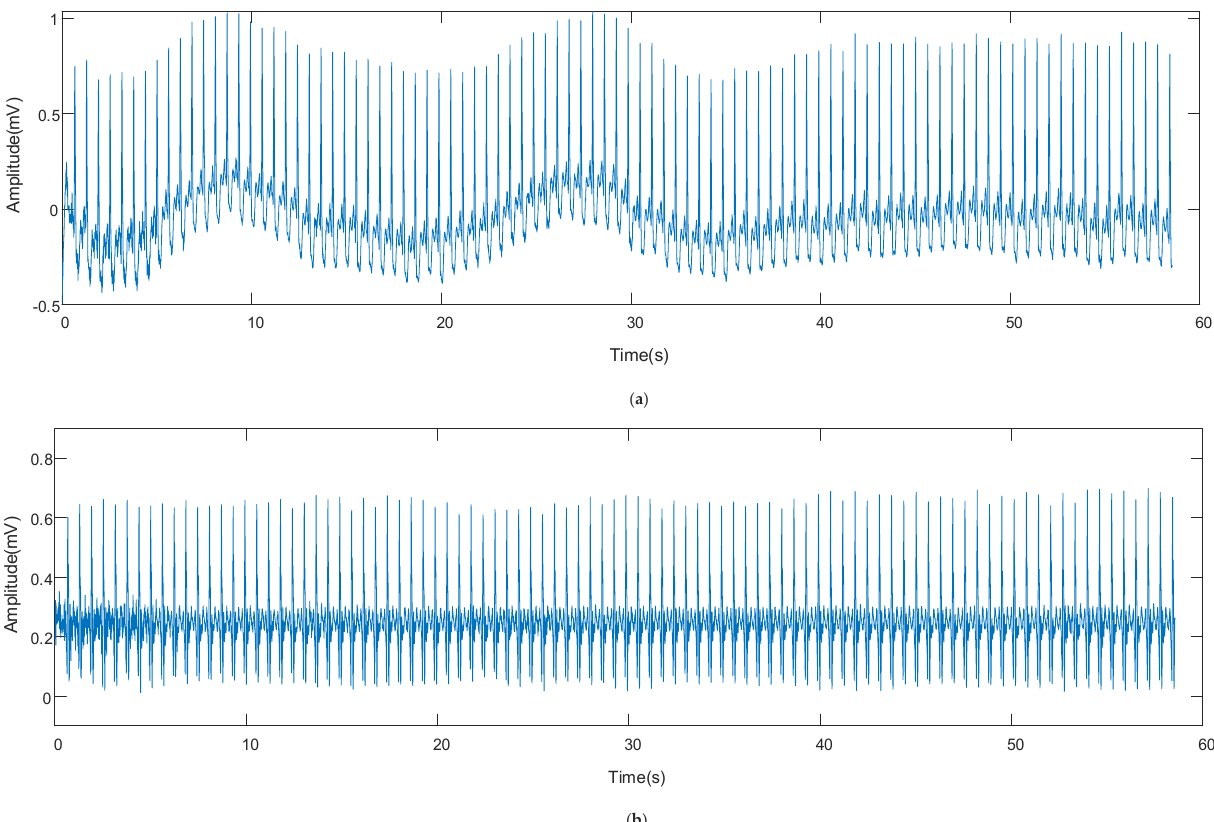
Figure 2. Results of pre-processing. ( a ) The original ECG signal; ( b ) The pre-processed ECG signal. By comparison, the baseline drift in the original ECG signal is eliminated by moving average filtering and its amplitude is adjusted to the 0–1 range by normalization.